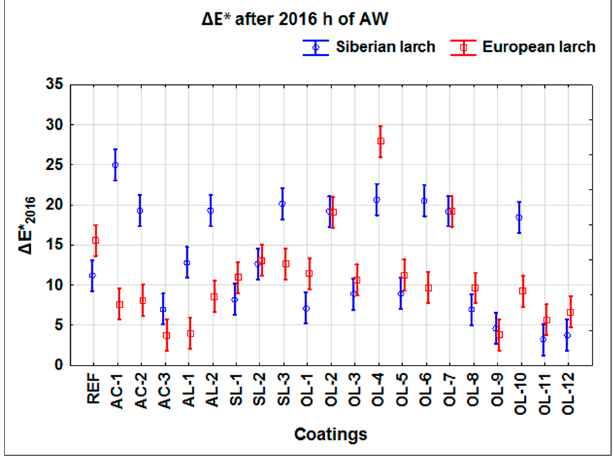
Figure 4. The total colour difference of acrylate, alkyd, synthetic ( A ) and oil-based ( B ) coating systems applied to Siberian larch during artificial weathering lasting 168, 504, 1512 and 2016 h.